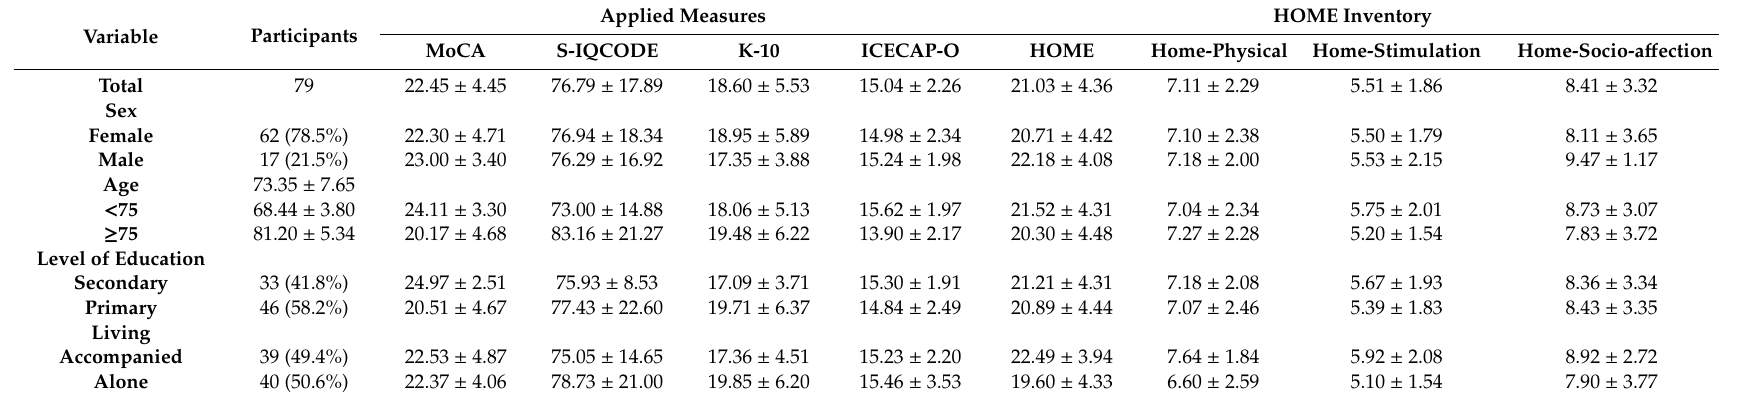
Table 1. Sociodemographic, environmental, cognitive and psychological characteristics of the